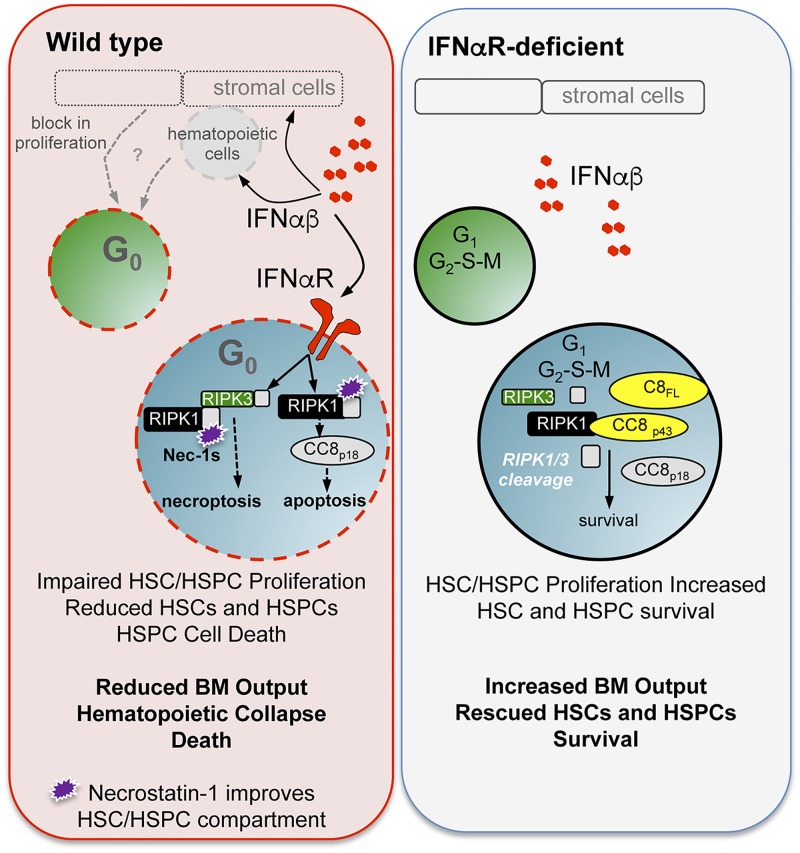
Summary model.Ixodes ovatus ehrlichia results in lethal shock-like infection and hematopoietic collapse. During infection of WT mice (left panel), type I IFN levels were elevated in the bone marrow, inducing hematopoietic stem cell (HSC) and progenitor (HSPC) loss. Type I IFNs restricted entry into the cell cycle, and type I IFN receptor (IFNαR) stimulation induced HSPC cell death. IFNαR signals limited caspase 8 expression and activation, blocked RIPK1 and RIPK3 cleavage, and caused RIPK1-kinase dependent cell death. In the absence of IFNαR signaling (right panel), HSCs and HSPCs were more proliferative and exhibited improved survival. IFNαR-deficiency results in increased pro-caspase 8 (C8FL), cleaved caspase products (C8p43 and C8p18), and increased cleavage of RIPK1 and RIPK3, resulting in improved HSC/HSPC numbers and function.